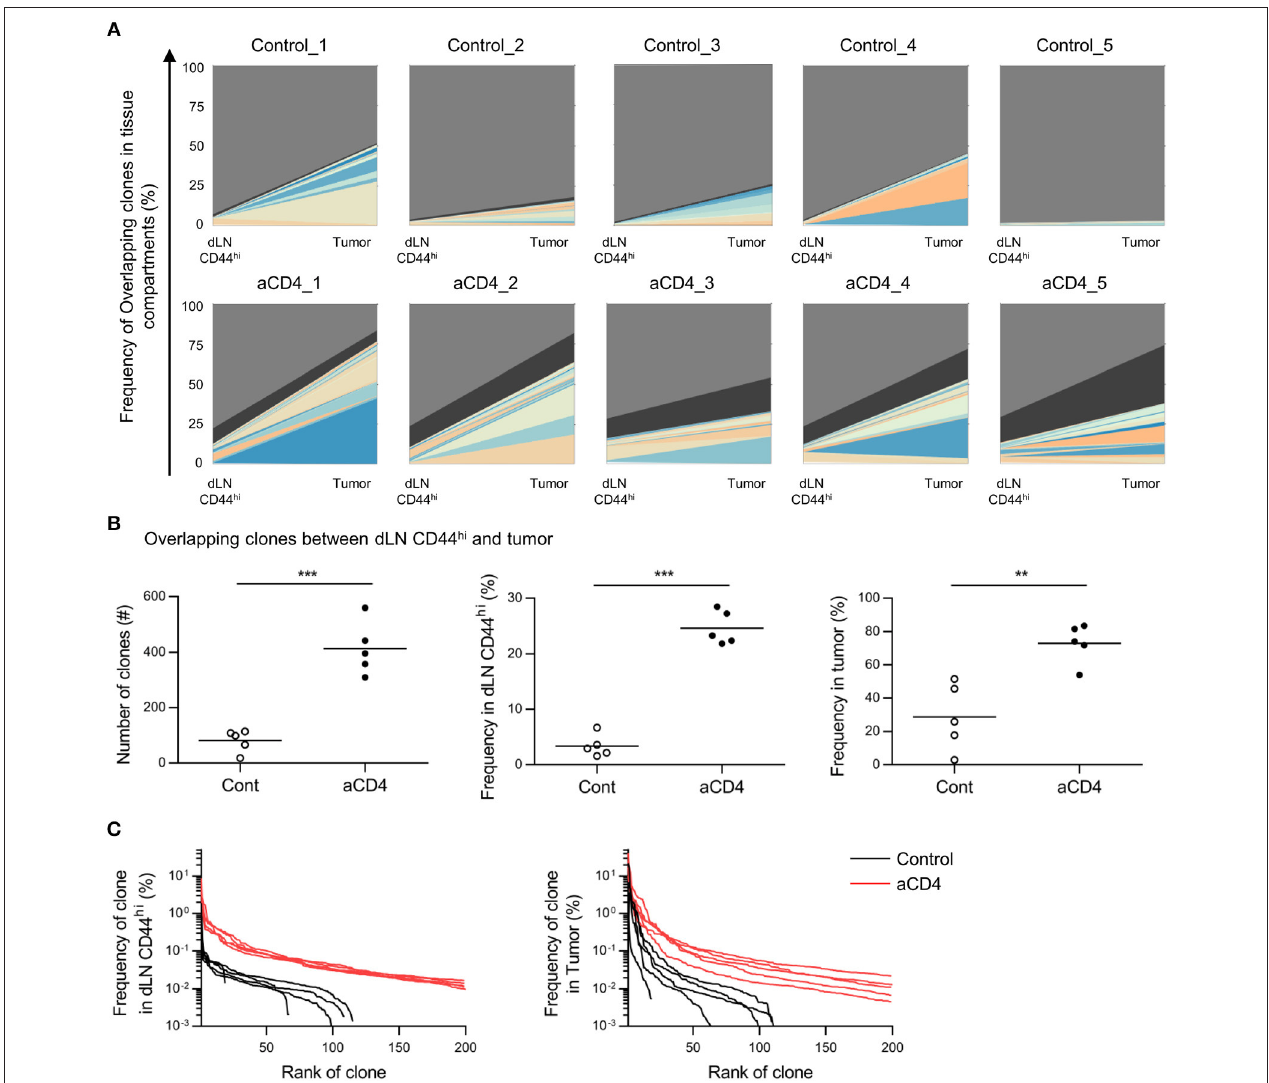
FIGURE 4 | Anti-CD4 mAb treatment increased the dLN-tumor overlap. Mice bearing B16F10 tumors were injected i.p. with anti-CD4 mAb on days 5 and 9, and were analyzed on day 14 after tumor inoculation. (A) Overlap analysis between the dLN CD44 hi and tumor in individual mice. Plots show the top 20 clones overlapping between dLN CD44 hi and tumor, as well as the clones whose frequency were below the top 20 (black) and non-overlapping (gray) clones. (B) Overlapping clones between the dLN CD44 hi and tumor. The total number (left), combined frequency in the dLN CD44 hi (middle), and combined frequency in the tumor (right) were compared. (C) Distribution plots of overlapping clones between the dLN CD44 hi and tumor. The x-axis represents each overlapping clone in the descending order of frequency, and the y-axis represents the frequency of each overlapping clone in the dLN CD44 hi (left) or the tumor (right). All figures present the data for TCR β . Two-sided unpaired Student’s t -tests ( n = 5). ** P < 0.01; *** P <